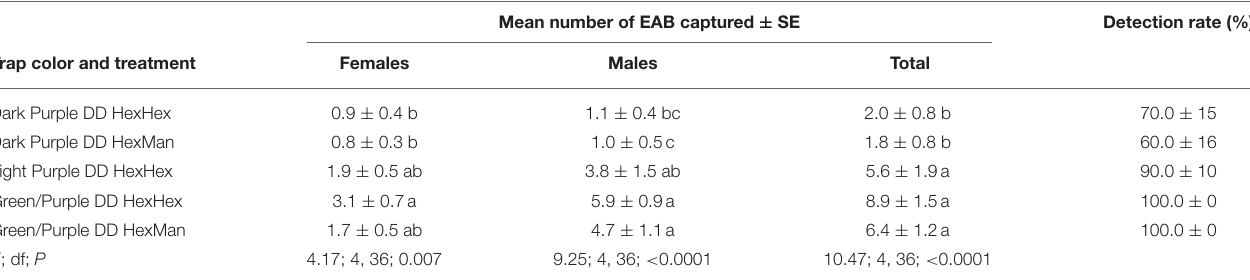
TABLE 3 | Mean number ( ± SE) of A. planipennis captured and detection rate (percentage of traps that captured at least one beetle) in Experiment 2 that compared different colored double-decker (DD) traps along the edge of a forest stand at Legg Park, Ingham County Michigan with a very low emerald ash borer population level in